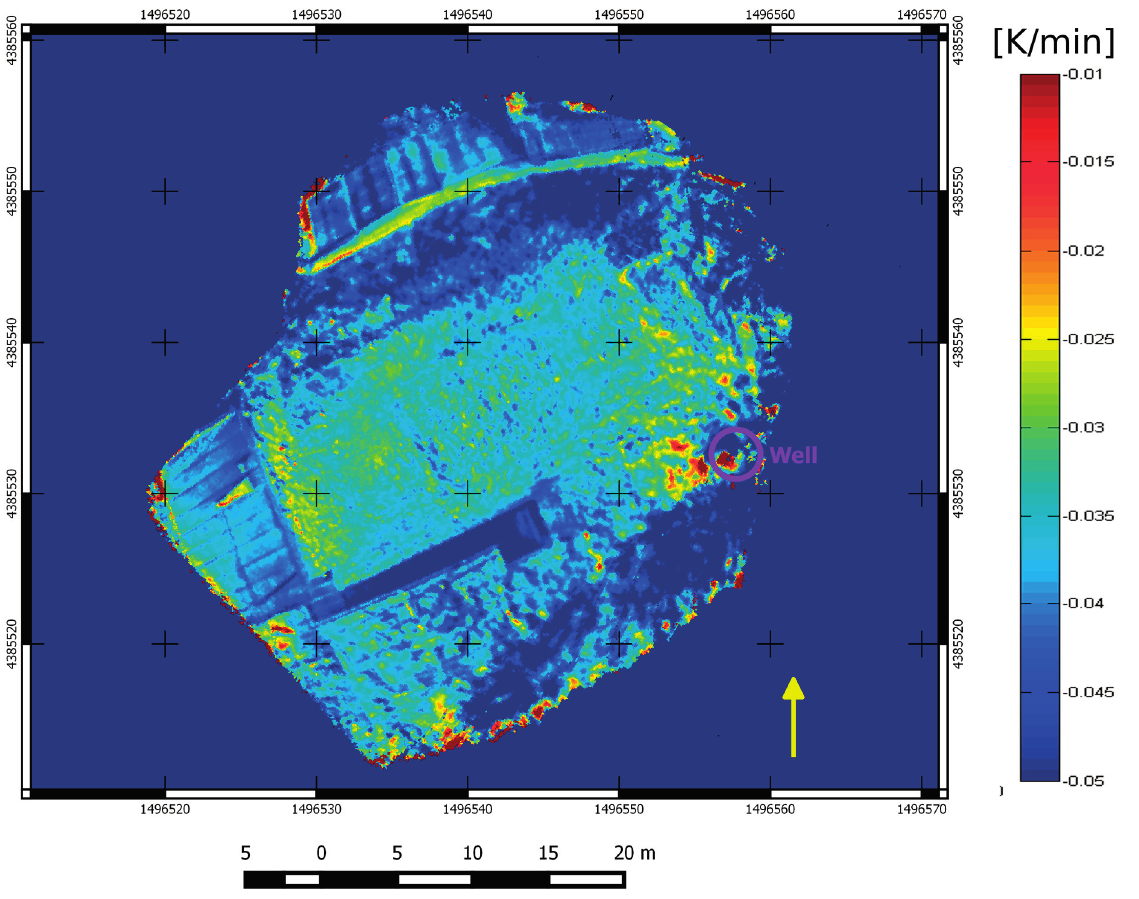
Figure 7. The thermal map of the night thermal gradient (NTG) index (in Kelvin/minute, negative values), resulting from the merging of many thermograms and processing temperature over time.